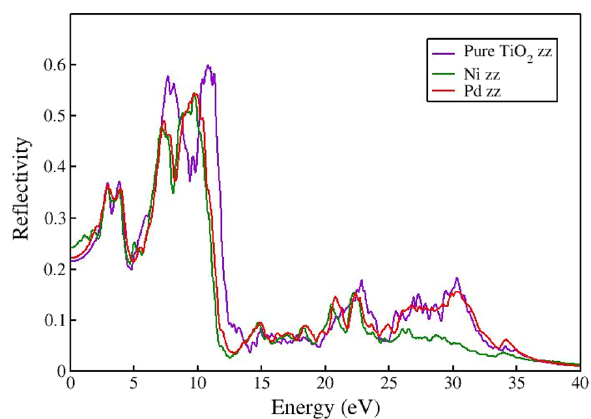
Fig. 6 Reflectivity of Ni, Pd and Pure TiO